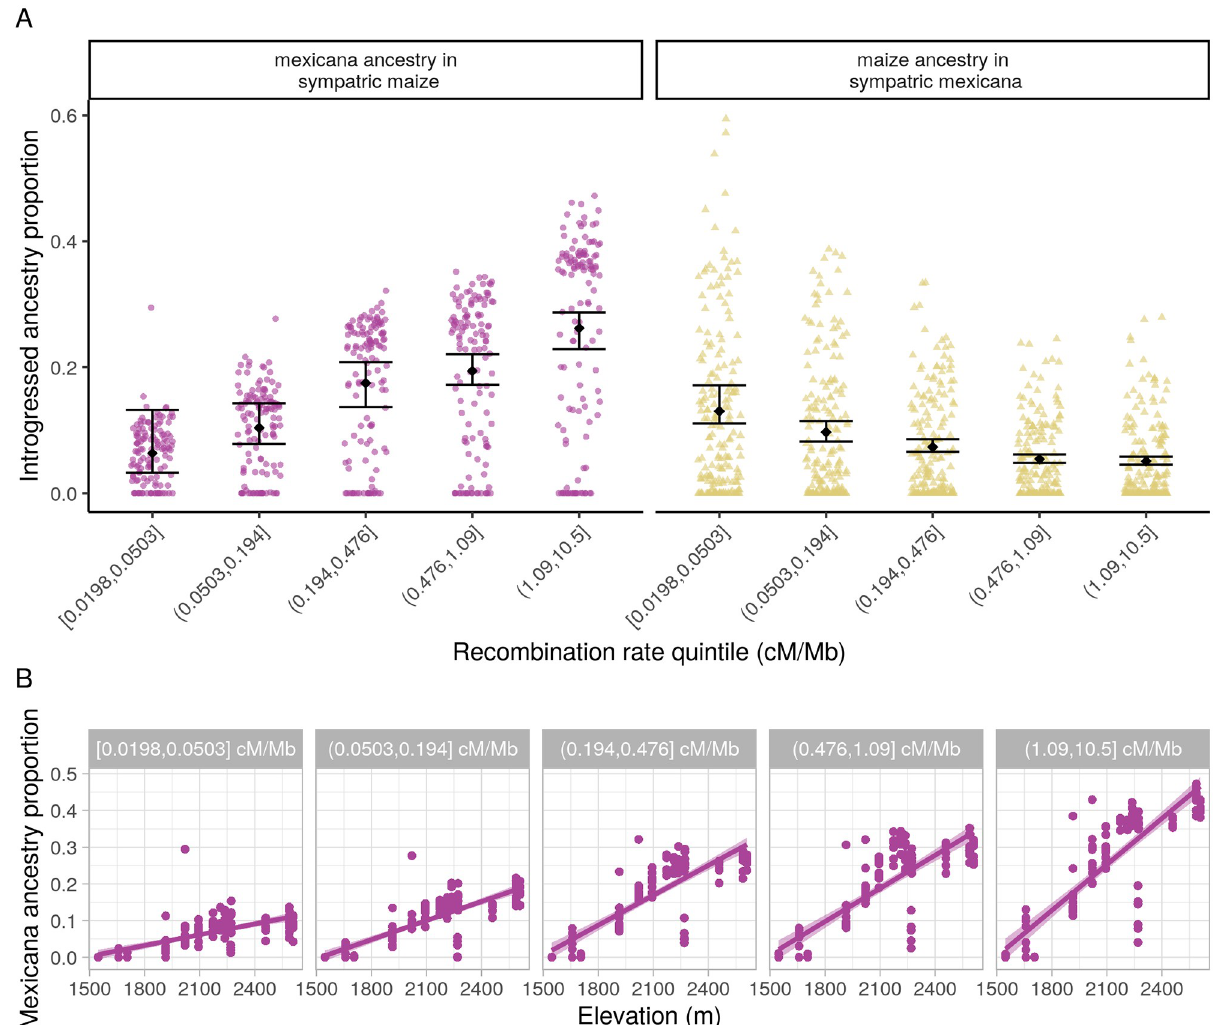
Fig 4. . (A) Introgressed ancestry by recombination rate . Inferred average genomewide introgressed ancestry in sympatric maize and mexicana individuals (NGSAdmix K = 3), by recombination rate quintiles. Group mean and 95% confidence interval based on bootstrap percentiles (n = 100) are depicted in black. Introgressed ancestry estimates for each individual are shown as points and points are jittered for better visualization. (B) Slope of mexicana ancestry introgressed into maize populations across elevation for each recombination rate quintile, based on NGSAdmix estimates. Each point is a sympatric maize individual and lines show the best-fit linear model for ancestry by elevation (with shaded 95% confidence interval), estimated separately for each